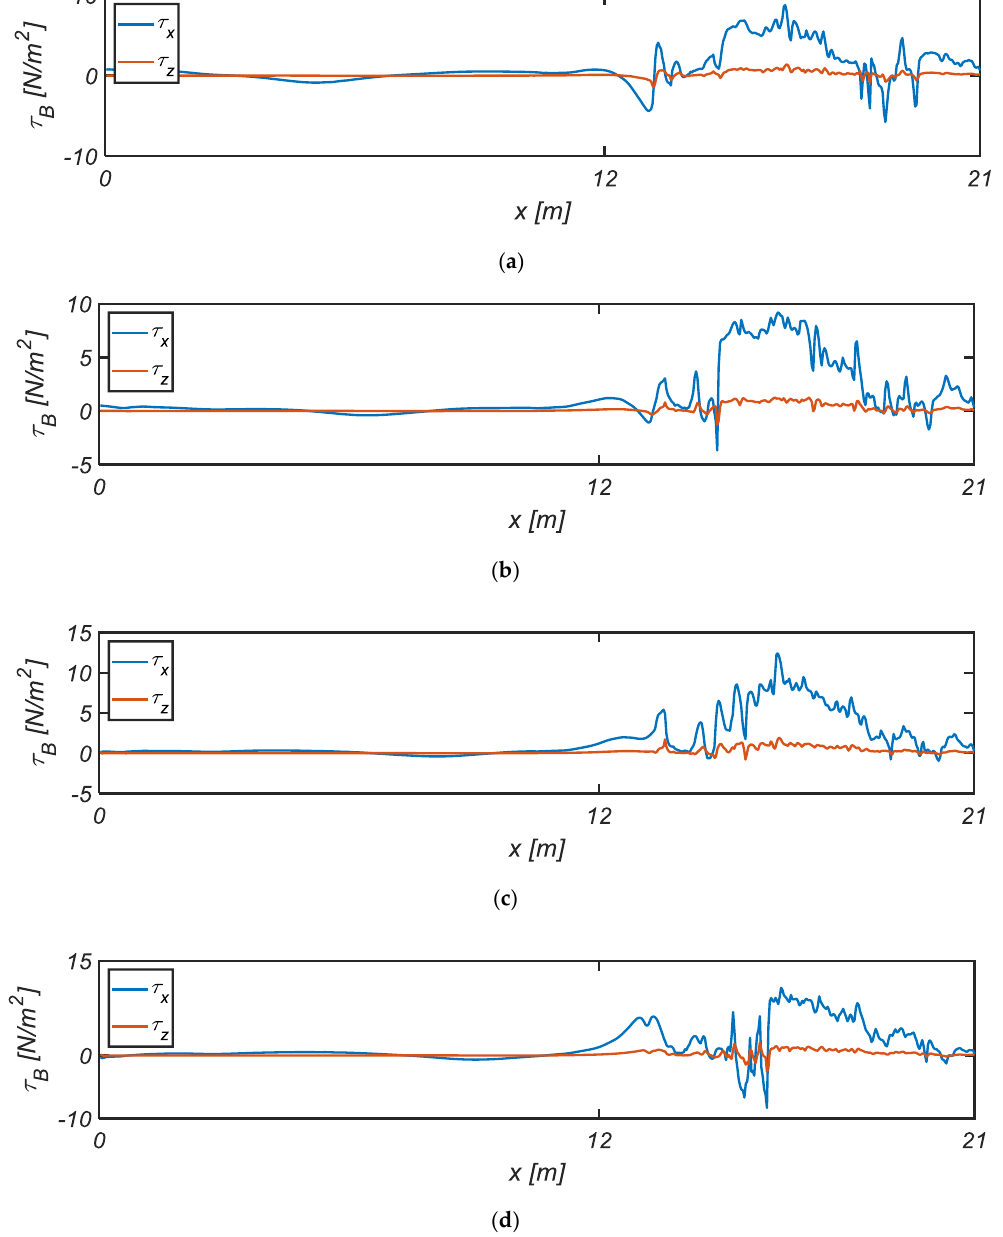
Figure 13. Variation of the bottom shearing stresses across the beach [Run 2]. ( a ) at t = 78.55 s; ( b ) at t = 79.15 s; ( c ) at t = 79.55 s; ( d ) at t = 80.0 s.